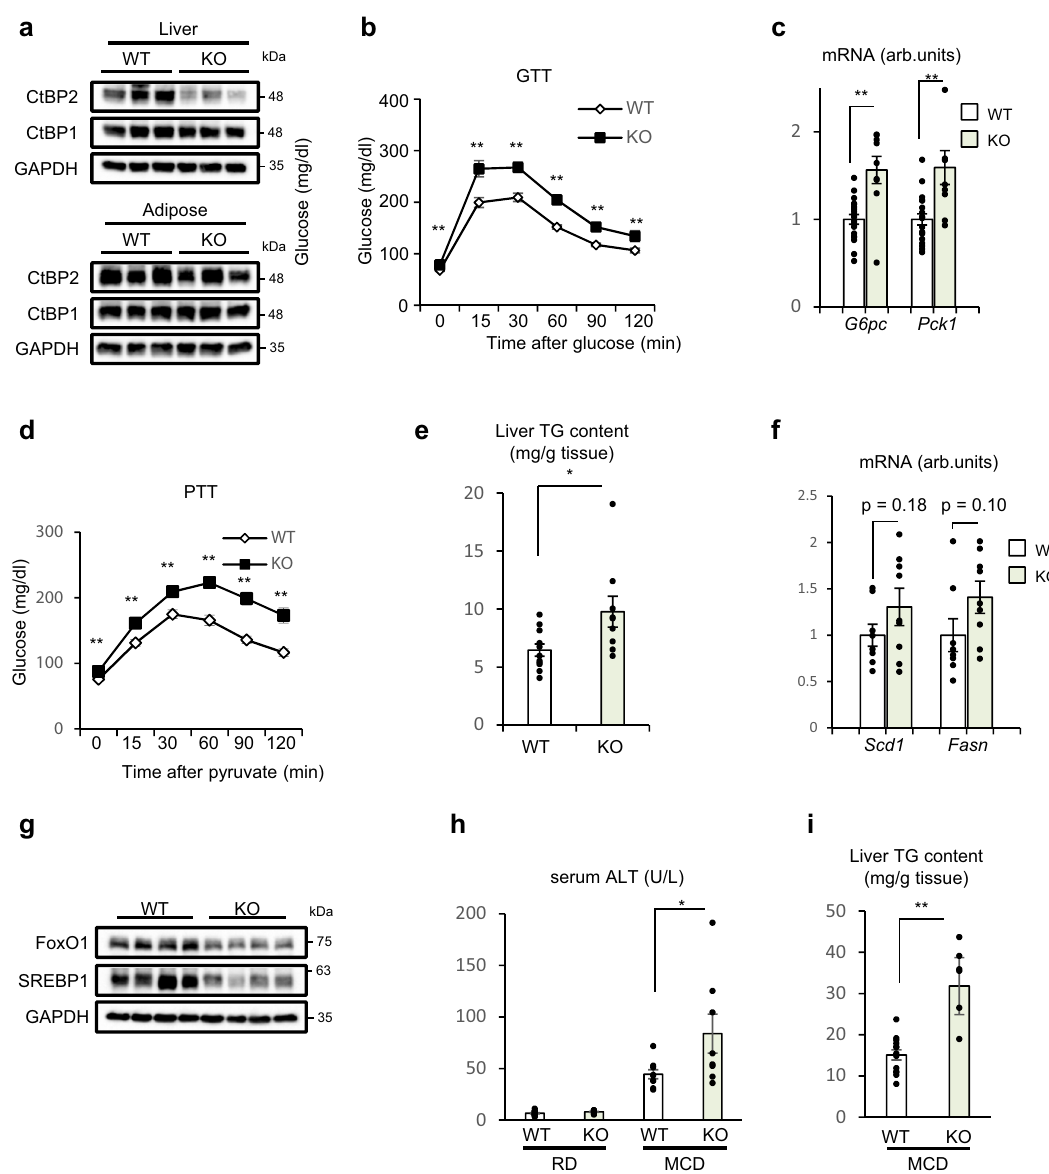
Fig. 5 CtBP2 de fi ciency in liver leads to obesity-associated metabolic disturbances. a Liver-speci fi c CtBP2-de fi cient mice (KO) maintained on a